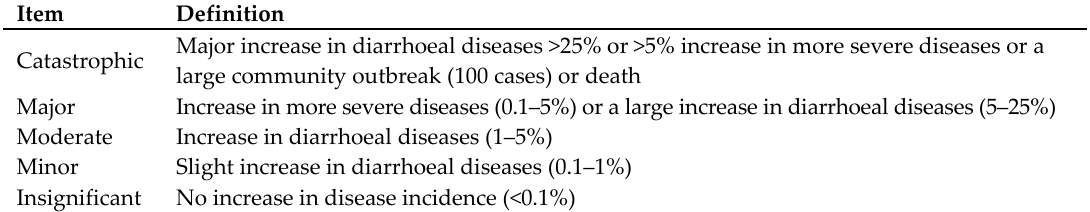
Table 4. Suggested definitions of severity of consequences of hazards based on an increase of endemic disease in the community [45].